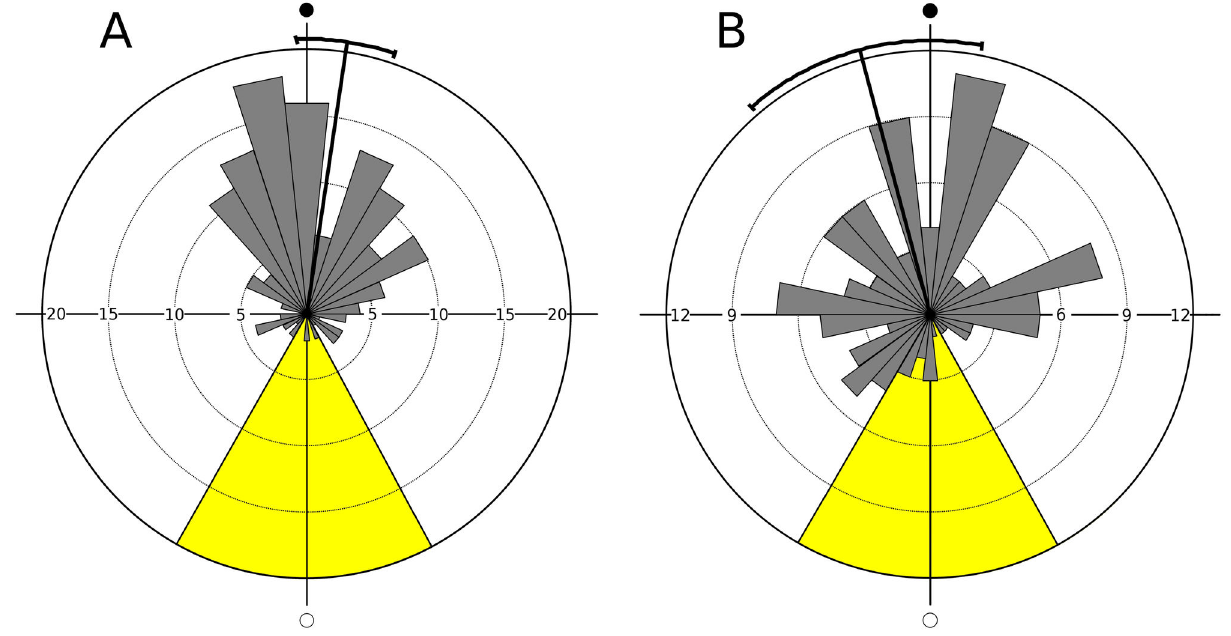
Figure 4. Circular plot for daily molt frequencies over the lunar cycle (experiment 1) - calculated separately for males (A, N = 152) and females (B, N = 122). Mean angular direction and its 95% confidence interval are indicated. Open circle = natural full moon, filled circle = natural new moon; period of exposure to artificial moonlight (three nights before and after the day of full moon) indicated in